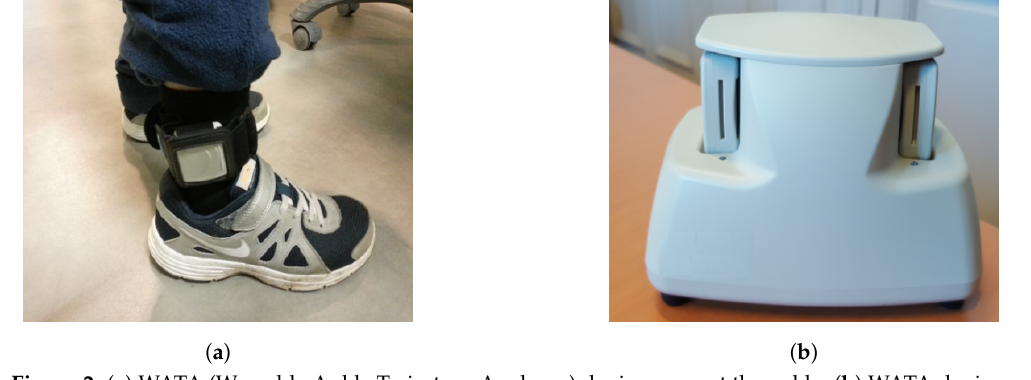
Figure 2. ( a ) WATA (Wearable Ankle Trajectory Analyzer) device worn at the ankle. ( b ) WATA devices connected to their